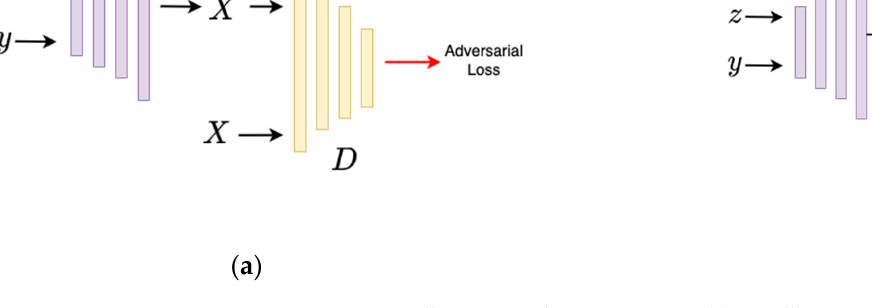
Figure 1. Vanilla GAN and Siamese GAN. ( a ) Vanilla GAN. ( b ) Siamese GAN.